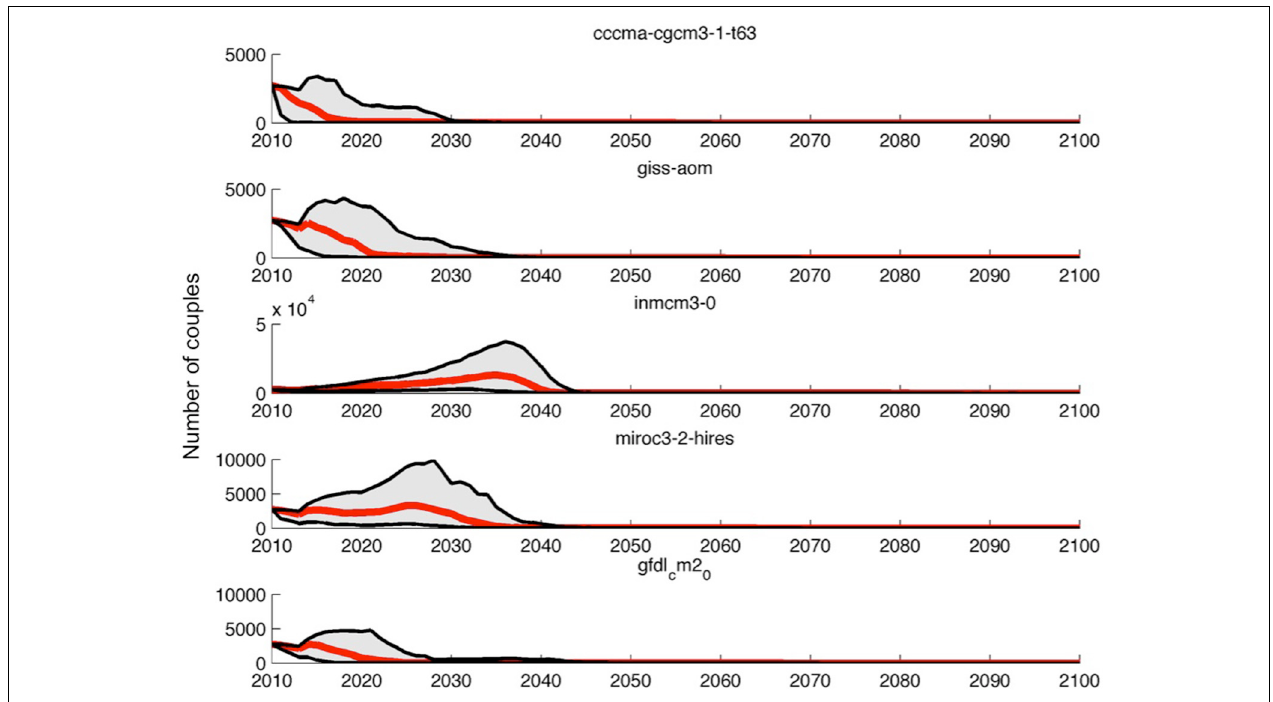
FIGURE 6 | Projections of the Adélie penguin population at Edmonson Point based on stochastic sea ice extent anomalies forecasts from five AOGCMs. For each AOGCM, the median population trajectory (thick red line) and the 95% envelope (gray area), from 200 stochastic simulations are